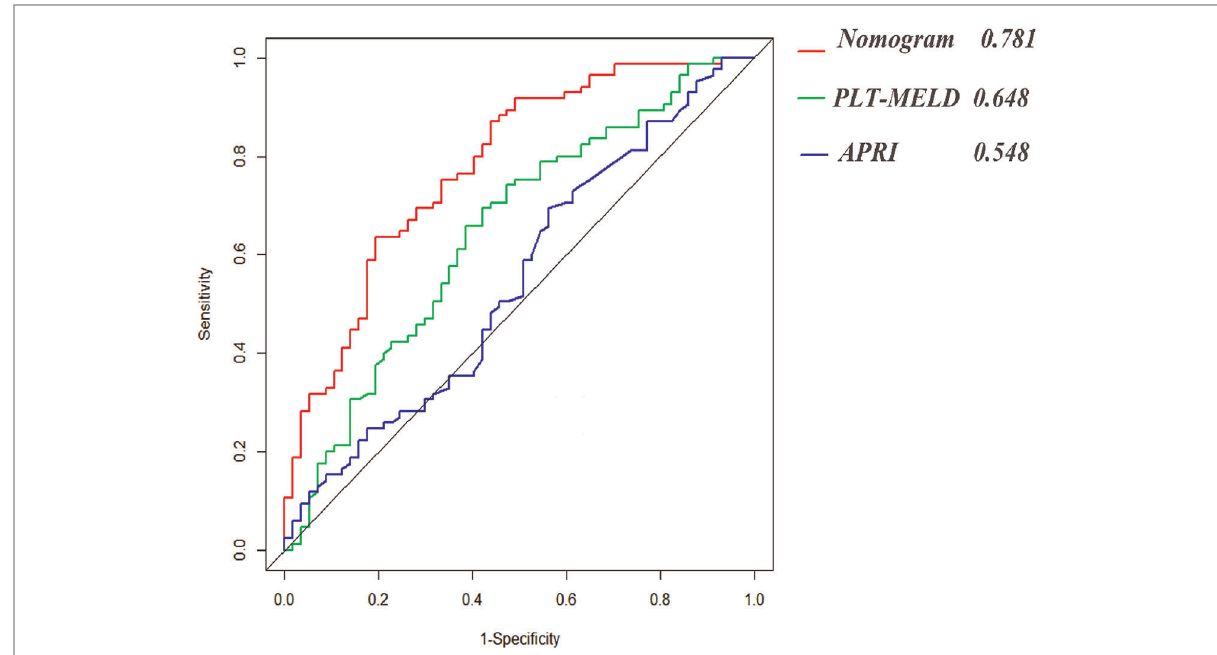
FIGURE 4 Area under receiver operating characteristic (ROC) comparison of nomogram, PLT-MELD and APRI.